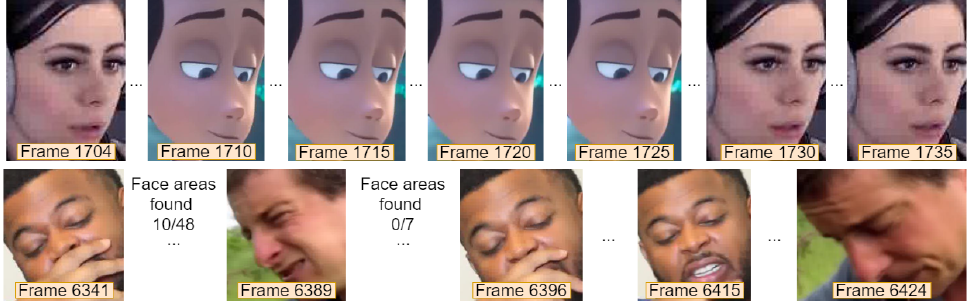
Figure 4. The examples of two video sequences, on which the HeadHunter face detector had many failures.